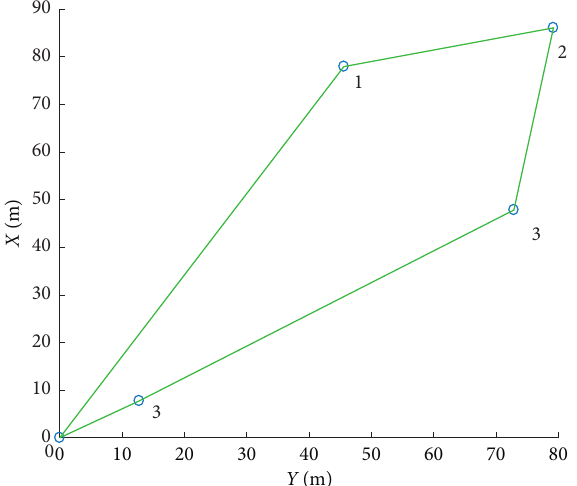
Figure 15: Planned access order at the beginning of the third subcycle.